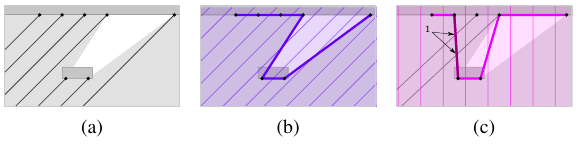
Figure 12: Inconsistency between the surface and the laser beams (a) An object hides a part of the wall behind. (b) Prismatic coordinate system: The reconstructed surface does not fit everywhere with the actual surfaces, but is not pierced by the laser beams. (c) Cartesian coordinate system: The reconstructed surface is in- tersected by two laser beams (1).